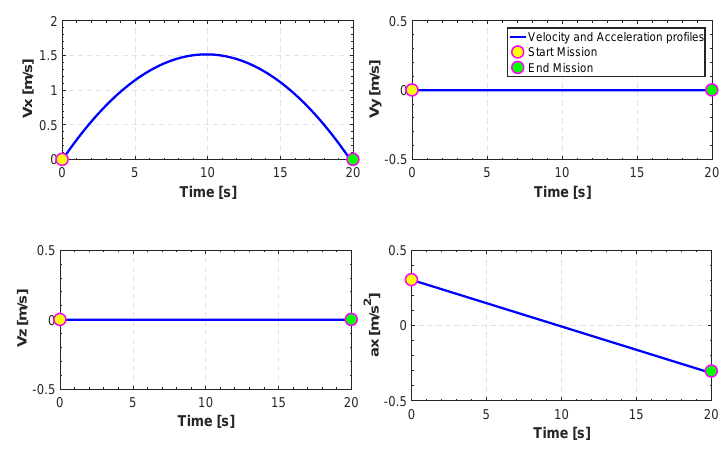
Figure 10. Translation of velocities and acceleration in FL.